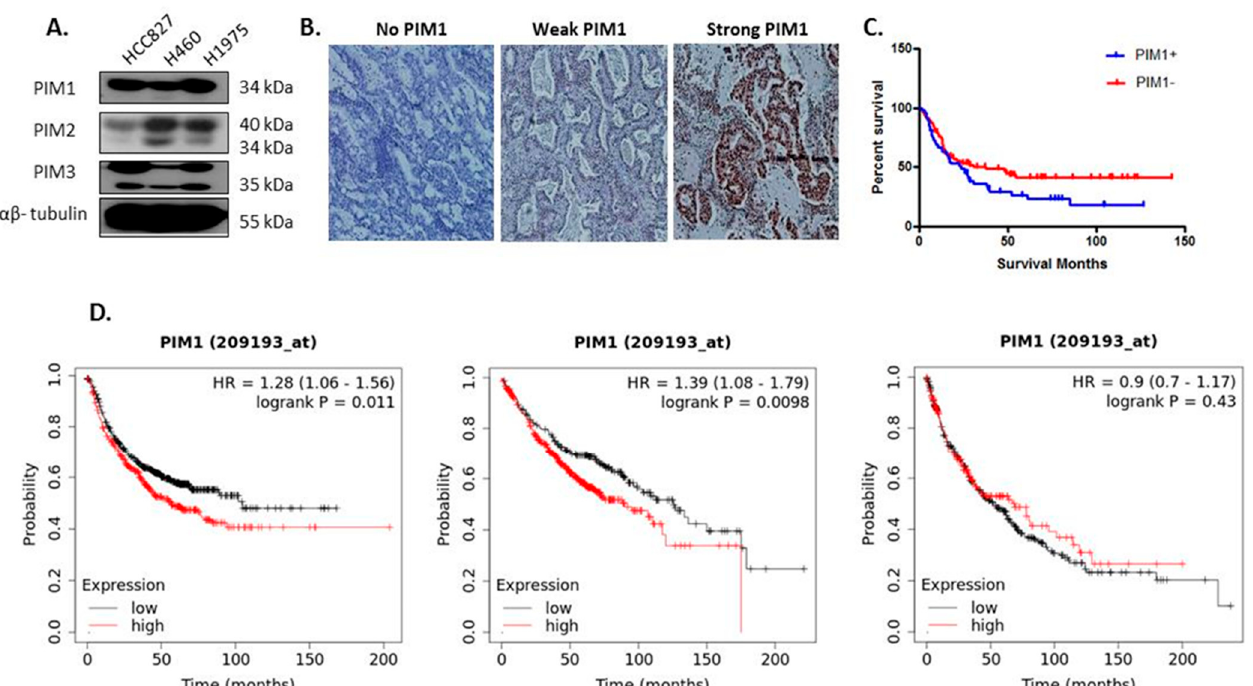
Figure 1. PIM1, PIM2 and PIM3 expression in NSCLC cell lines and PIM1 biomarker potential in NSCLC patients. ( A ) Representative Western blot images showing PIM1, PIM2 and PIM3 expression in HCC827, H460 and H1975 cell lines. Original Western blots in Figure S3. ( B ) Representative images of PIM1 staining. No expression, weak nuclear and strong nuclear and moderate cytoplasmic PIM1 positivity in NSCLC tissue from a Grade 2 tumor is shown at low ( × 10) magnification. ( C ) Overall PIM1 positive patients (i.e., those with an Allred score of ≥ 3) had a median survival time of 23.67 months in comparison to 37.32 months in the PIM1 negative group ( n = 134, Log-rank test p = 0.056). ( D ) KM Plotter survival analysis of PIM1 mRNA levels in lung squamous and adenocarcinoma patients ( n = 982) is associated with reduced progression free survival time (HR = 1.28, p < 0.05). A sub-analysis of adenocarcinoma cases only ( n = 719), PIM1 mRNA expression is associated with poorer overall survival (HR = 1.39, p < 0.01). There was no association between PIM1 mRNA expression and overall survival in a sub-analysis of squamous carcinoma cases ( n = 524, HR = 0.9, p = 0.43).